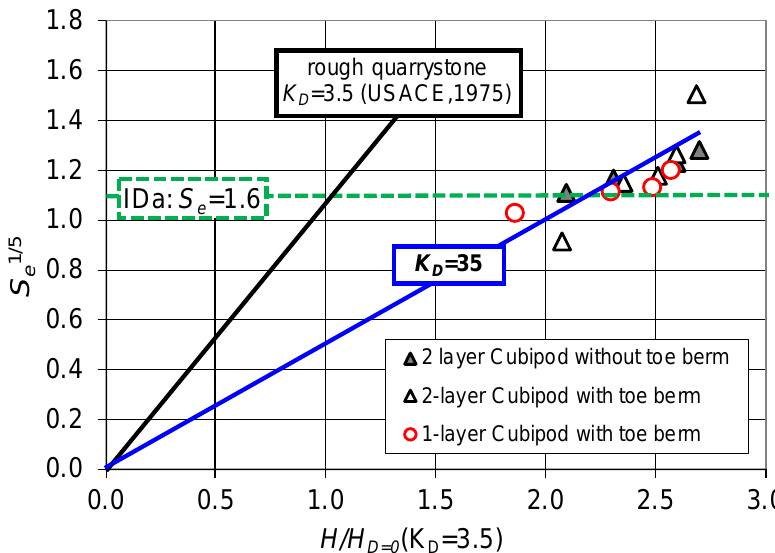
Figure 5. Accumulated linearized equivalent dimensionless armor damage ( S e 1/5 ) as a function of dimensionless wave height in wave breaking conditions for single- and double-layer Cubipod ® armors with and without toe berm.